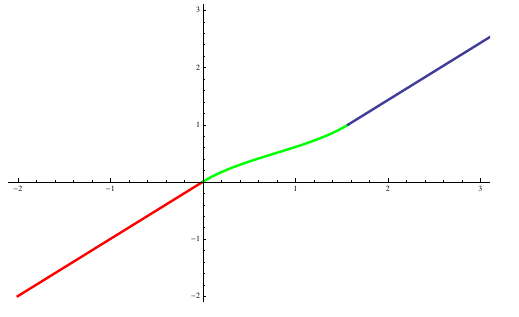
q E , ‘ = 2 C , = 1. 2 2 C